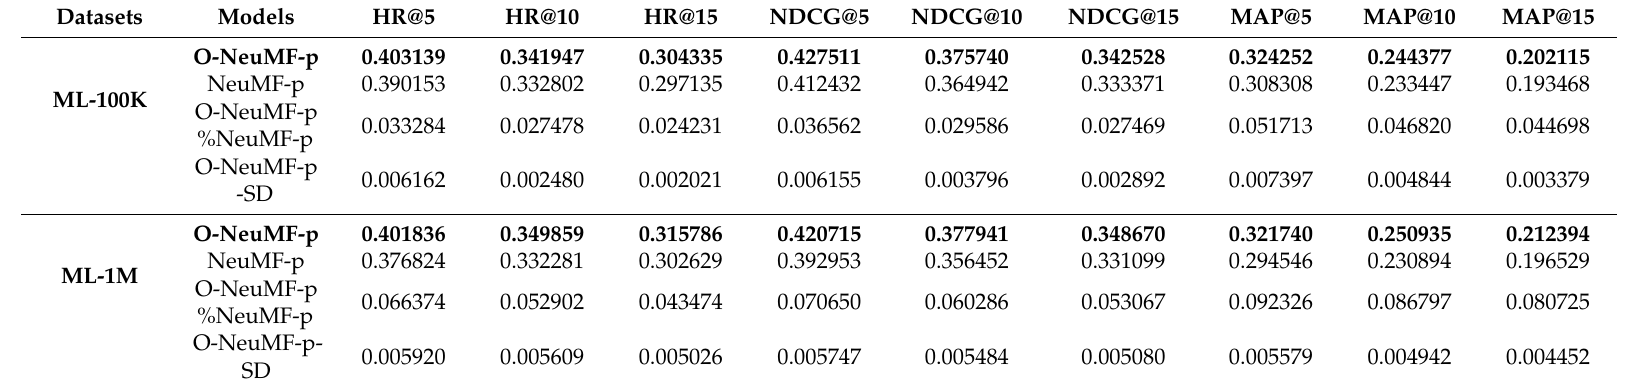
Table 3. Performance comparison of O-NeuMF-p and NeuMF-p based on HR@N, NDCG@N, and MAP@N. (N = 5, 10,